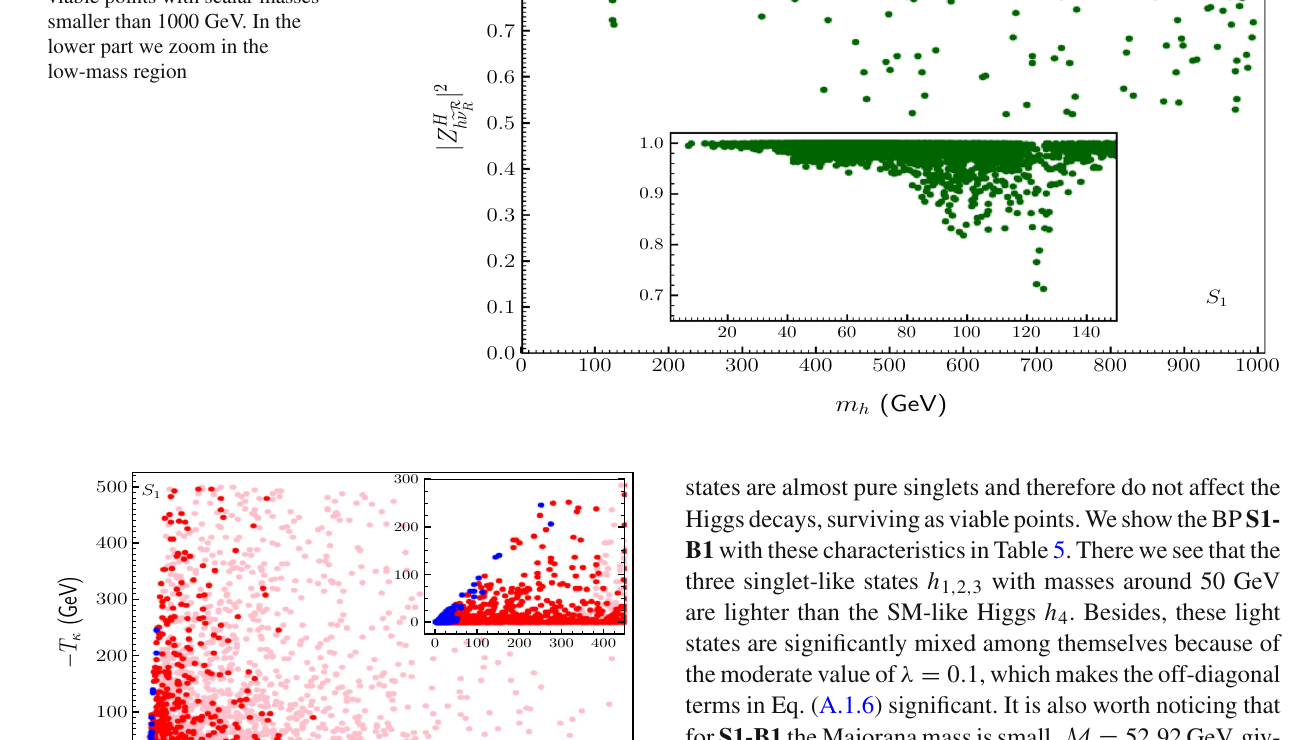
Fig. 6 The singlet component (cid:8) | Z H | 2 of the singlet-like i h (cid:6) ν R iR scalars h versus their masses, for S 1 . We only show here viable points with scalar masses smaller than 1000 GeV. In the lower part we zoom in the low-mass region